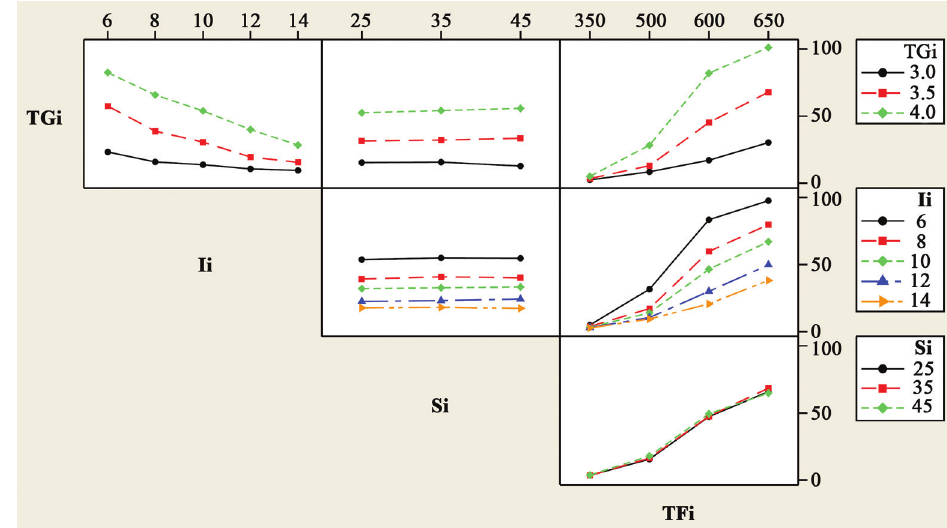
Fig. 6. Interaction plots for stop-line delays in I